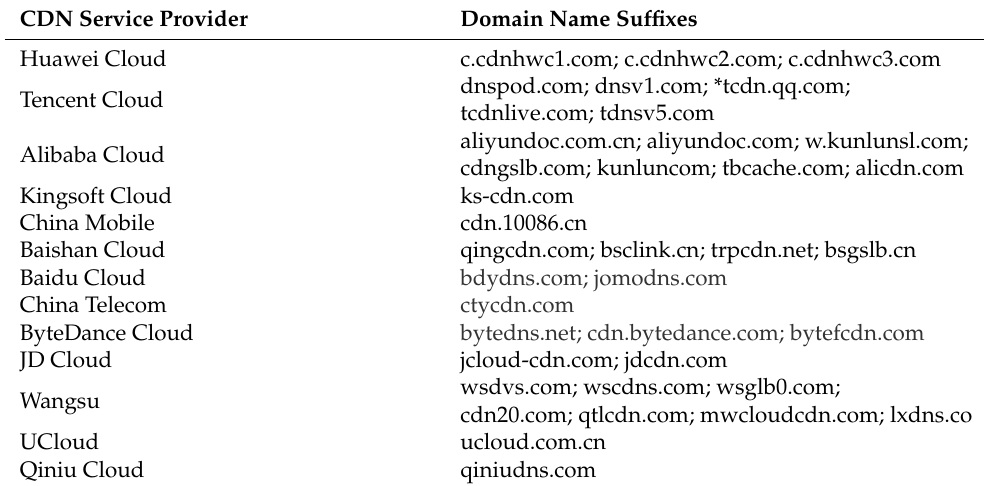
Table 1. CDN service providers and corresponding domain name